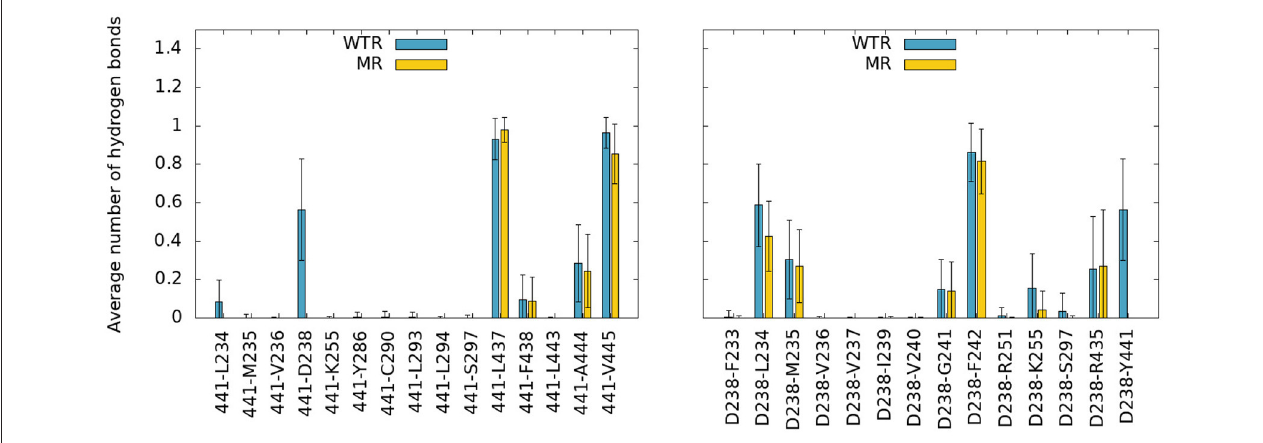
FIGURE 7 | Hydrogen bonds of residue 441 (left) and D238 (right) with any other protein residue, calculated over R01-400 for the WTR (blue) and the MR (yellow).